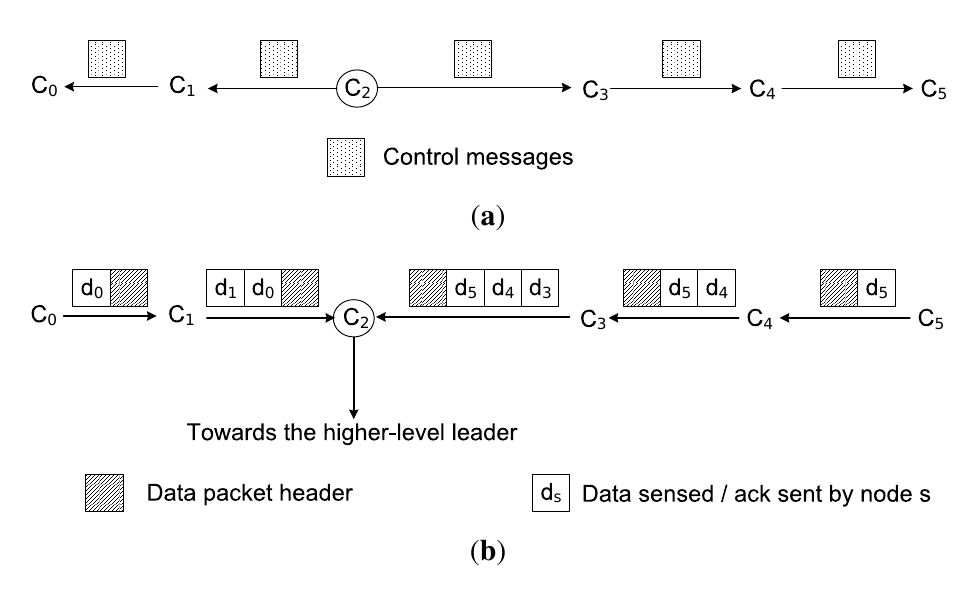
Figure 19. Communications in a chain. ( a ) Control message dissemination; ( b ) Sending data towards the lower-level